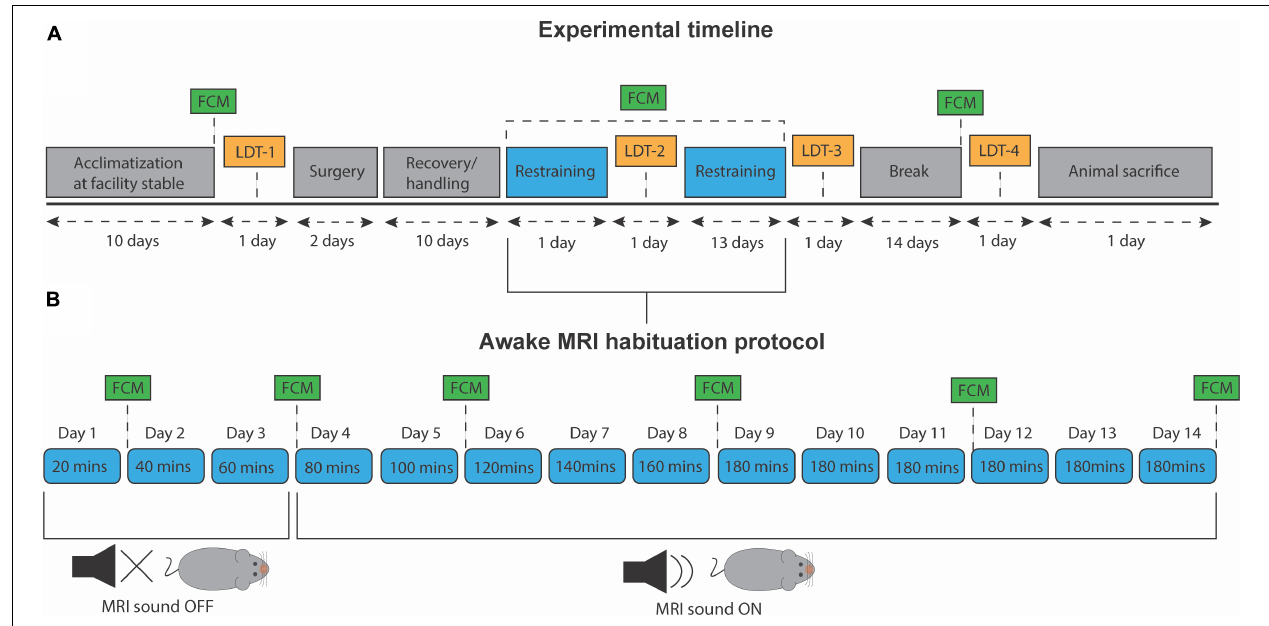
FIGURE 1 | Experiment timeline and awake MRI habituation protocol. (A) Timeline for all experimental procedures. LDT, light/dark test. FCM, fecal corticosterone metabolite assessment. (B) Progressive awake MRI habituation protocol. Twenty minutes were added to each session per day, up to a total of 180 min. MRI sound was played from day 4 and